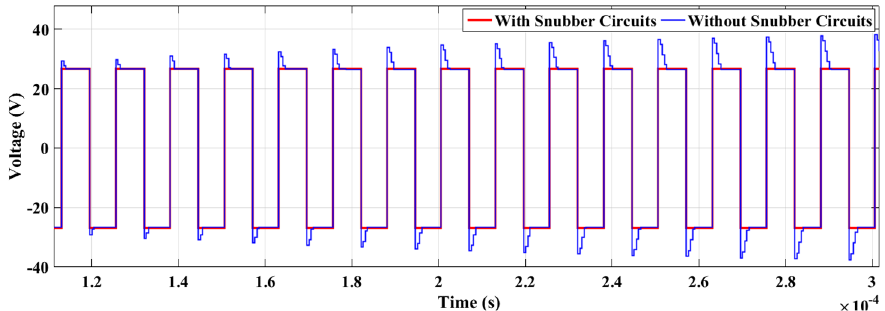
Figure 7. Improving the output waveform of the GaN inverter using corresponding snubber circuits.